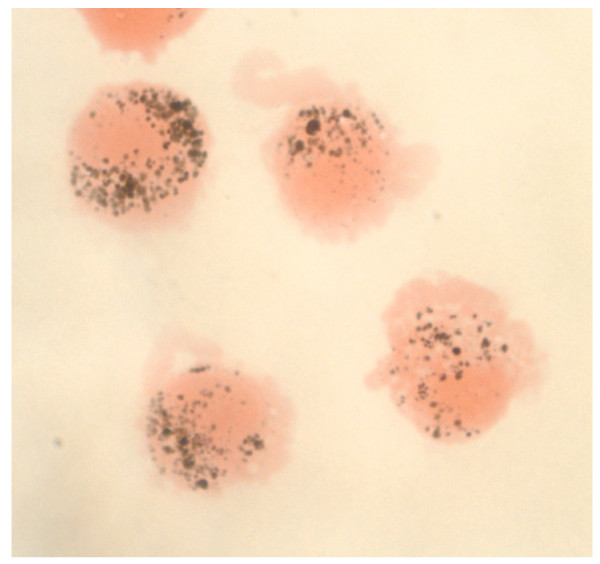
Carbon loading of human alveolar macrophages (AM) from an adult exposed to biomass smoke in Malawi. AM were obtained by bronchoalveolar lavage. Image taken under oil immersion (x100). Black material represents phagocytised elemental carbon and the pattern of loading is compatible with moderate- to heavy-loading of AM in UF-CB exposed mice (Figure 1).